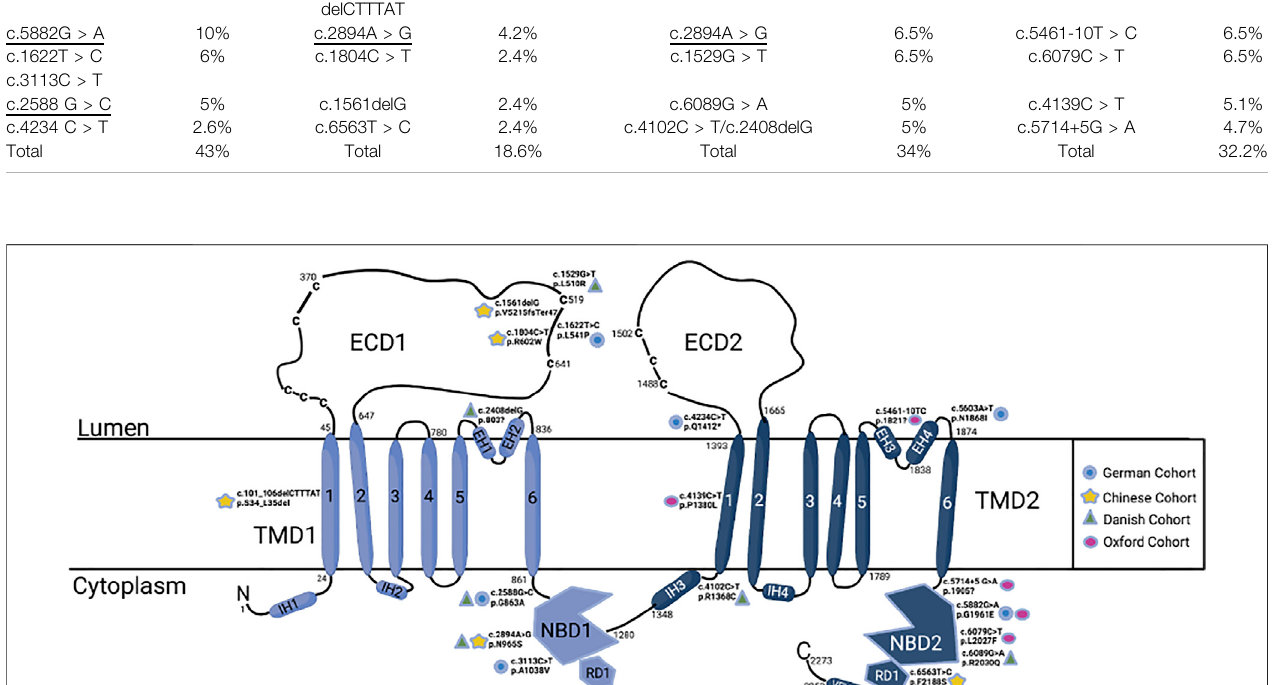
TABLE1| Showsthetop5mutationsineachpatientcohortandtheirprevalence.Thebottomrowshowscombinedprevalencewithinthecohortoutofallmutationspresent (not patients). The proportion of PAMs represented in any cohort was affected by the type of most common mutations. For example, the German cohort had an unnaturally high prevalence of SaCas PAM sites due to c.5882 G > A mutation. The underlined mutations are seen in more than one cohort. The Oxford cohort data was taken from Fry et al. German cohort Birtel et al. (2018)